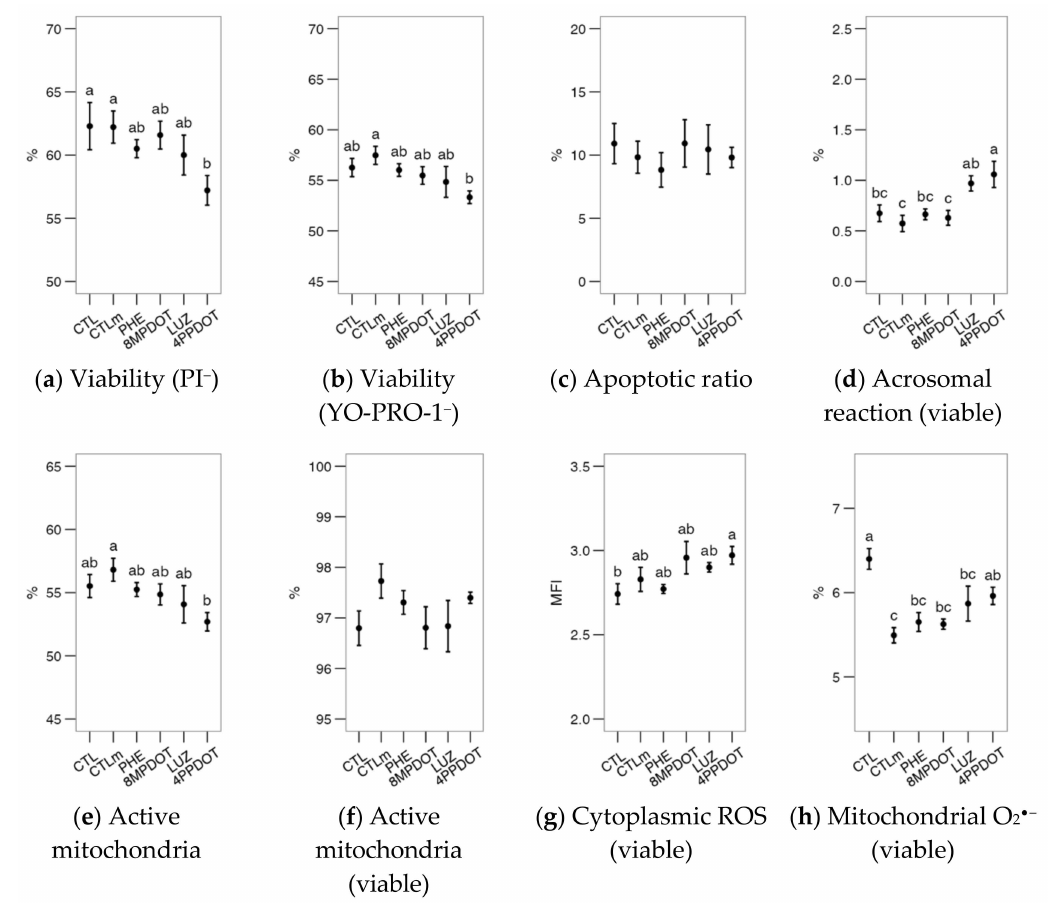
Figure 1. Effects on bull sperm physiological parameters of melatonin receptors agonists (PHE: Phenylmelatonin; 8MPDOT: 8-Methoxy-2-propionamidotetralin) or antagonists with 10 nM melatonin (LUZ: Luzindole; 4PPDOT: cis-4-Phenyl-2-propionamidotetralin); CTL: Control; CTLm: Control with 10 nM melatonin. Plots show mean ± SEM for each treatment of seven males. ( a ) Viable spermatozoa as maintaining membrane continuity (PI − ); ( b ) Viable, non-apoptotic spermatozoa (as YO-PRO-1 − ); ( c ) Apoptotic spermatozoa (YO-PRO-1 + ) as ratio of PI − ; ( d ) Acrosome-reacted spermatozoa (PNA + ); ( e ) Spermatozoa with active mitochondria (MitoTracker + ); ( f ) Spermatozoa with active mitochondria as a proportion of the viable population; ( g ) Cytoplasmic ROS production (H 2 DCFDA + ) of viable spermatozoa; ( h ) Spermatozoa with high mitochondrial superoxide production (MitoSOX + ) as a proportion of the viable population. Treatments not sharing the same letters differ significantly ( p <